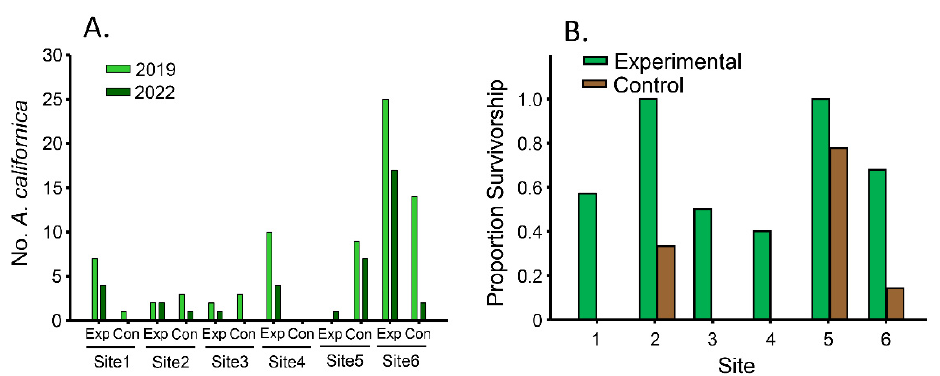
experimental at site 5 (Figure 4). In addition, the control at site 5 had two resprouts, the only two A. californica resprouts recorded.